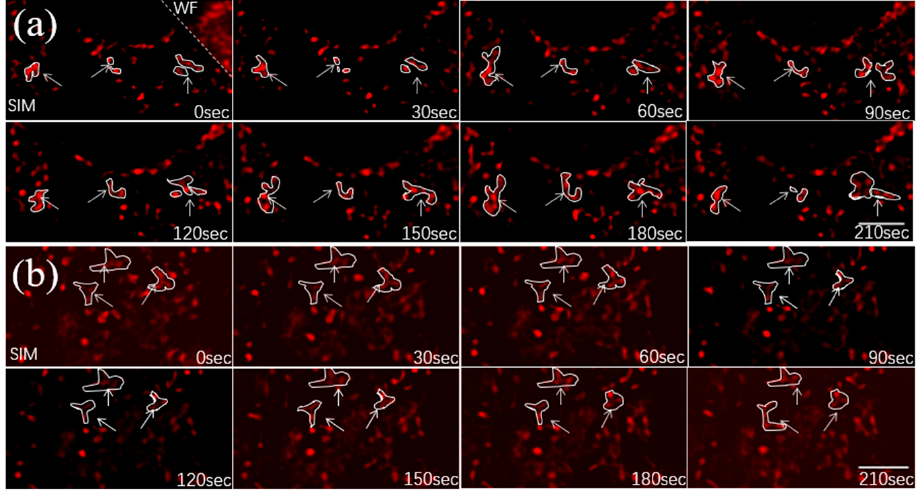
OSGIN1 gene overexpression cells were reconstructed by N-SIM algorithm. ( a ) OSGIN1 gene overexpression cell; ( b ) normal cell, scale bar is 3 µ